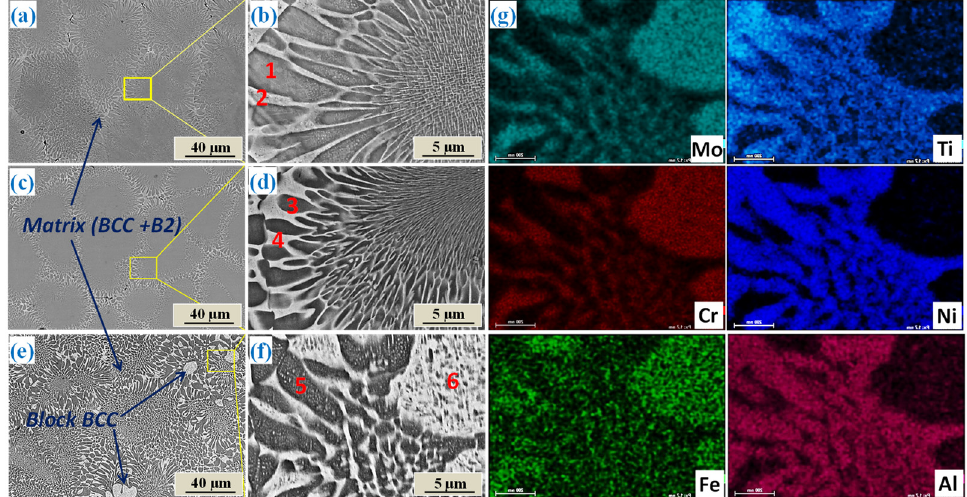
Figure 2. SEM backscattering electron micrographs of ( a , b ) AlCrFeNiTi 0.5 , ( c , d ) AlCrFeNiTi 0.5 Mo 0.1 , ( e , f ) AlCrFeNiTi 0.5 Mo 0.2 HEAs. ( b , d , f ) High-magnification images of areas marked by yellow squares in image ( a , c , e , g ). EDS elemental maps of various elements in AlCrFeNiTi 0.5 Mo 0.2 HEA, whose SEM image is shown in ( f ).